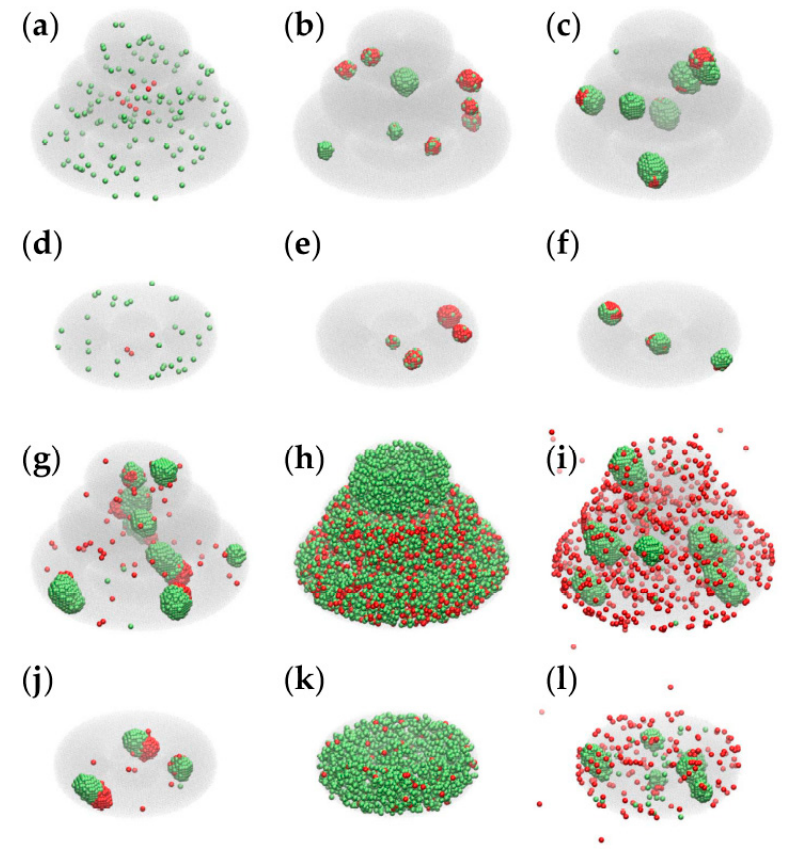
Figure 8. Results of MMC simulations performed with different model parameters. We used VMD [40] to depict the hydrogel as a translucent gray medium, peritumoral cells as green spheres and cancer cells as red spheres. ( a ) The initial state of the triple-layered structure; ( b , c , g – i ) the results of 2×10 4 MCS performed for the triple-layered structure with parameter sets 1–5, respectively (Table 1); ( d ) the initial state of the toroidal structure; ( e , f , j – l ) the result of 2×10 4 MCS conducted for the toroidal structure with parameter sets 1–5, respectively.